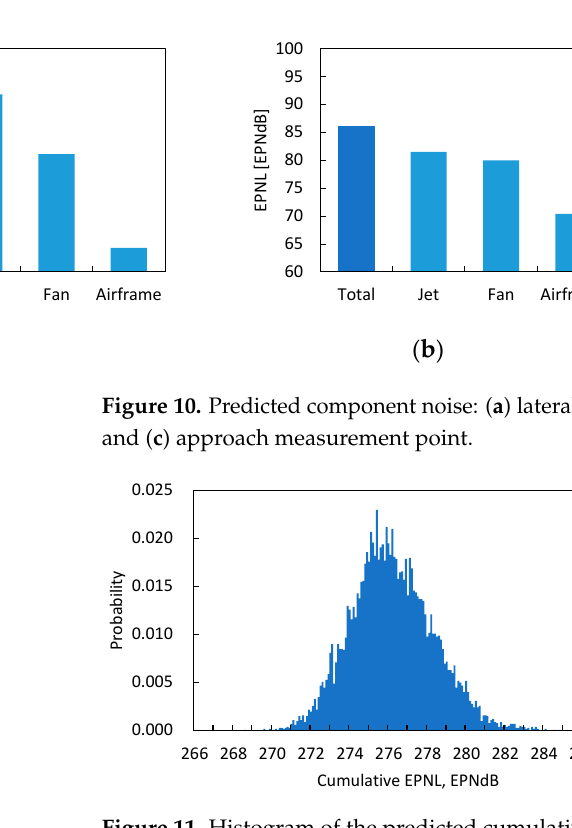
Figure 11. Histogram of the predicted cumulative noise.